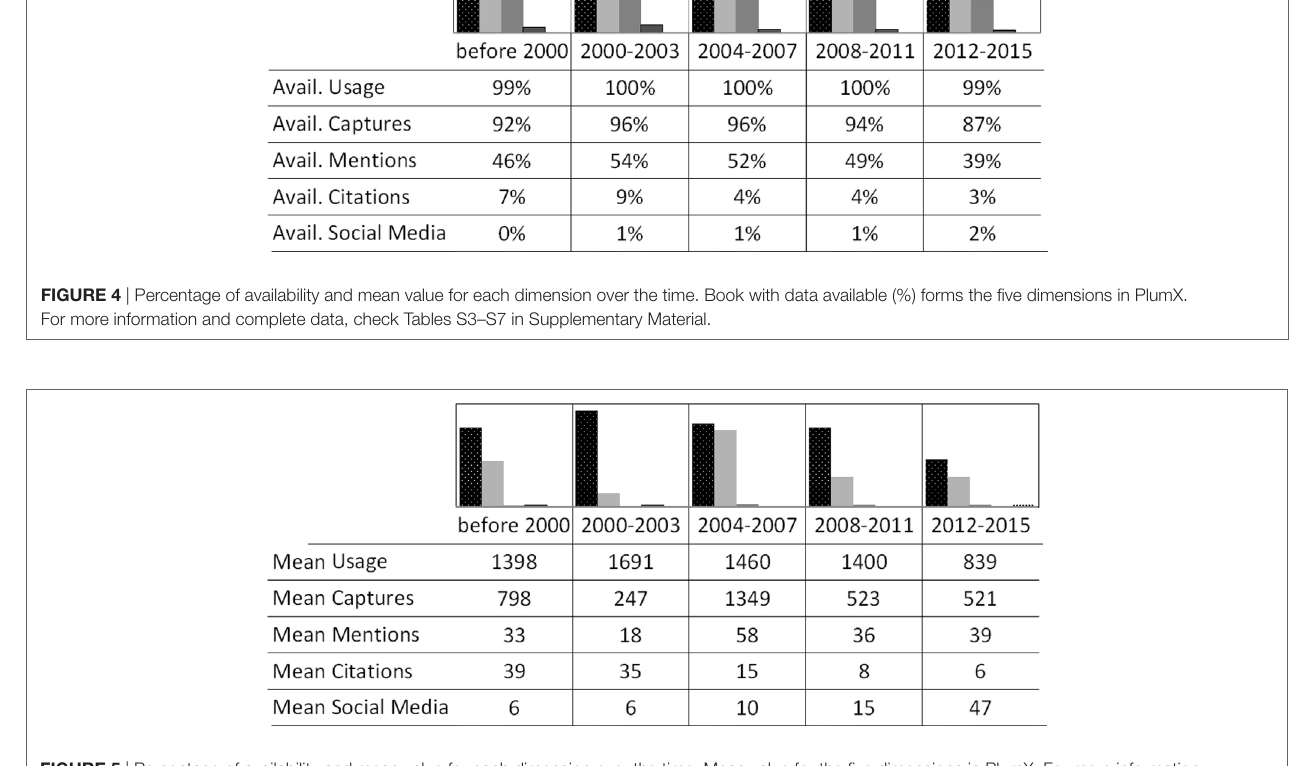
FigUre 5 | Percentage of availability and mean value for each dimension over the time. Mean value for the five dimensions in PlumX. For more information and complete data, check Tables S3–S7 in Supplementary